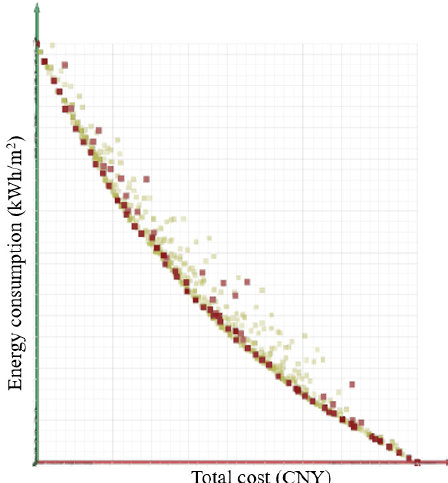
Figure 7. Pareto frontier solution set.